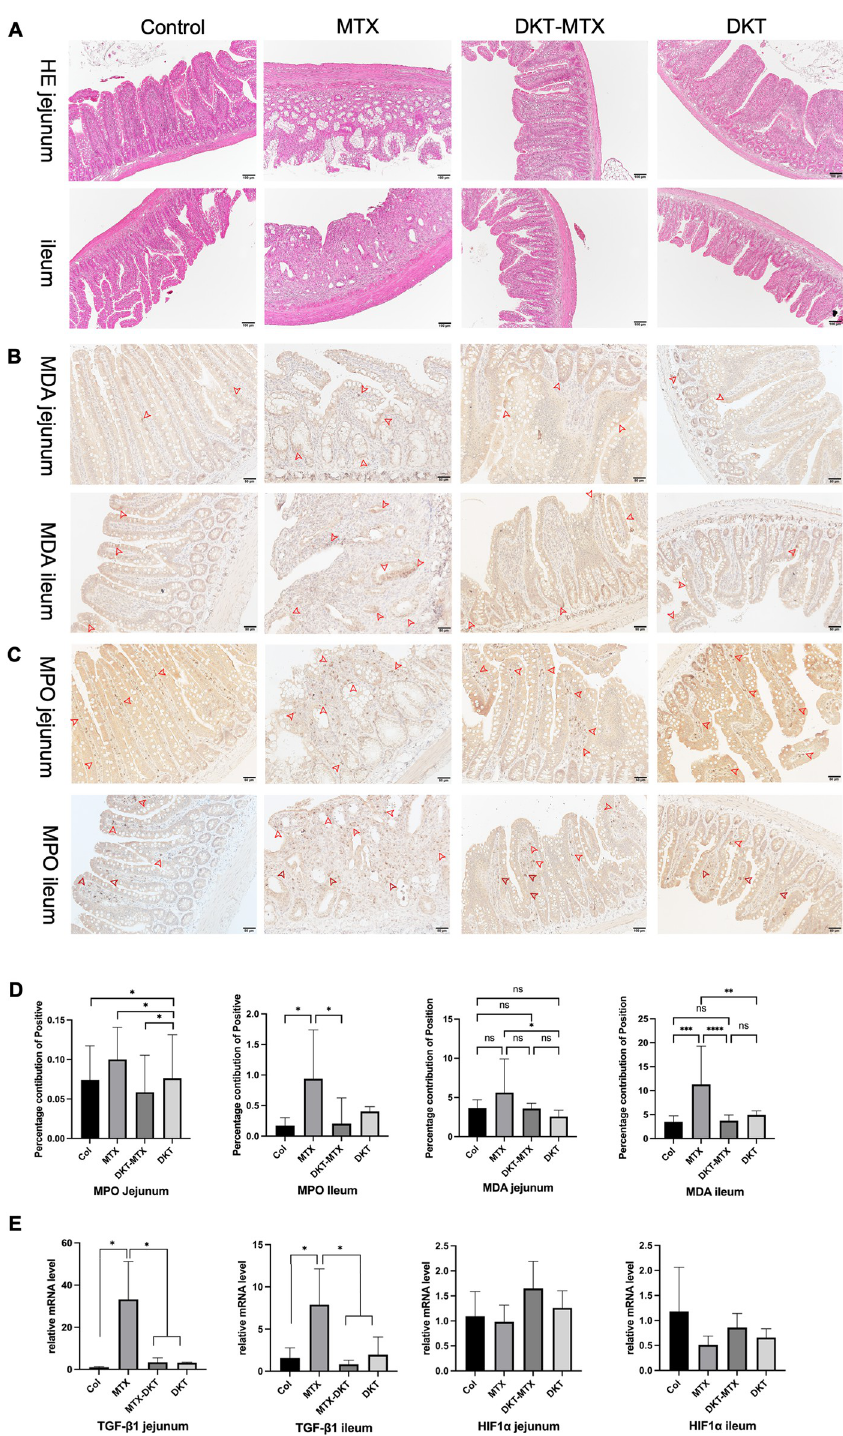
Fig 2. DKT attenuated MTX-induced inflammation and mucosal damage in the small intestinal mucosa. (A) HE staining showed the structural changes in all groups. Scale bar = 100 μ m. (B, C, D) The immunohistochemistry results showed a lower percentage contribution of positivity for (D) MDA (B) and MPO (C) in the jejunum and ileum of the DKT-MTX group than in those of the MTX group. For each criterion, the percentage contribution of positivity was calculated for at least 10 positions. Scale bar = 50 μ m. Data are represented as mean ± standard error of the mean. One- way ANOWA test, ns > 0.05, * p < 0.05. (E) RT-qPCR showed the expression of inflammation-related mRNA of TGF-